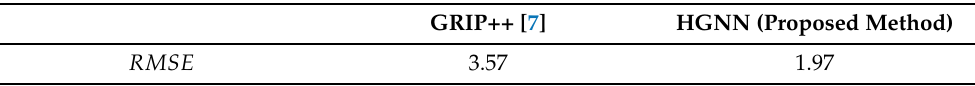
Table 3. Compariso n of RMSE errors with GRIP++ in highly interactive situations ( ∆ TTCP min ≤ 1 s).